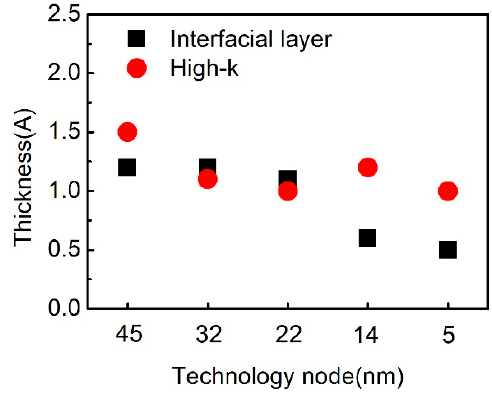
Figure 25. Interfacial layer and high-k dielectric thickness from 45 nm to 5 nm node.